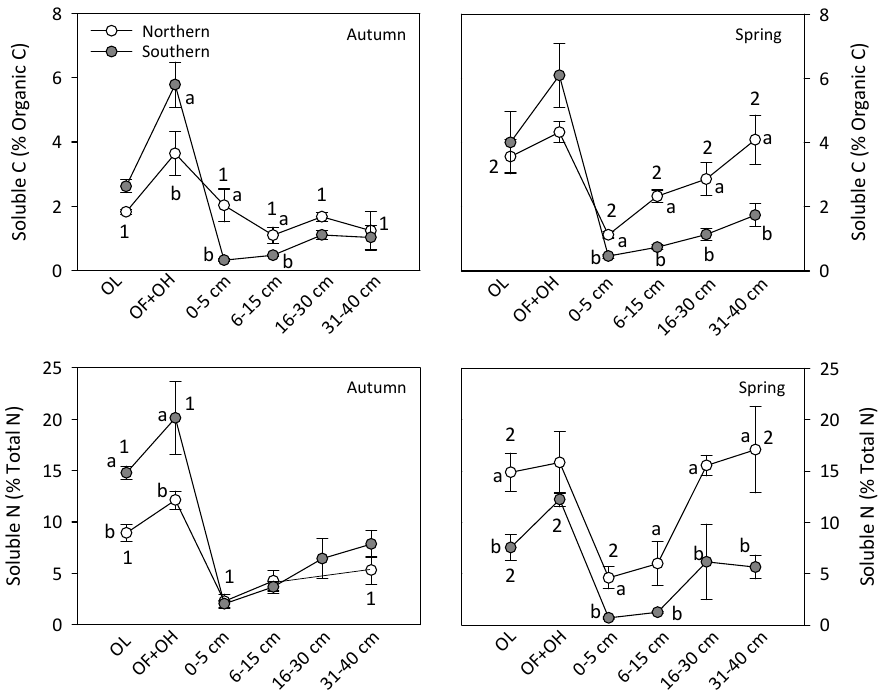
Figure 5. Soluble C and N fractions % of total C and N in the continuum forest floor ‐ mineral soil of a northern and a southern beech forest. Values are means ± standard error; n = 18 samples (6 sampling plots, 3 replicate analyses). Different lower ‐ case letters indicate significant differences between sites; differences between seasons are indicated by different numbers (two-way ANOVA followed by post-hoc Holm-Šídák method; overall significance level =